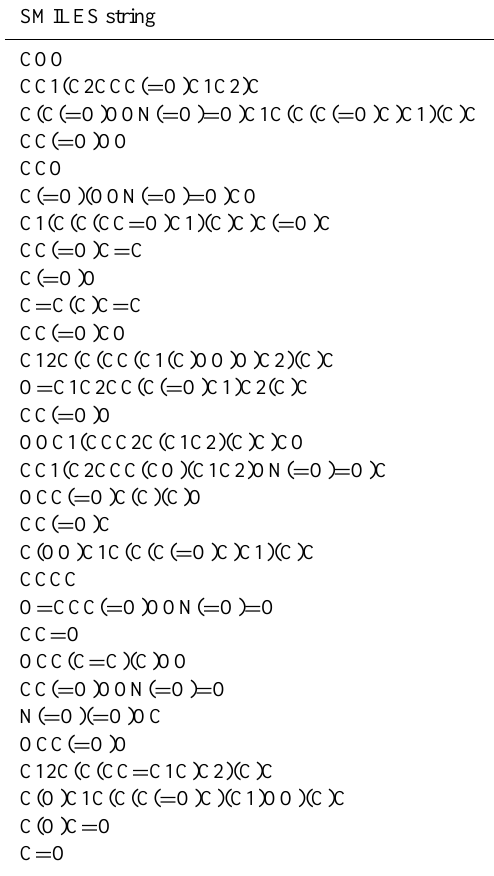
Table A1. To replicate the predicted vapour pressure and density predictions covered in Sect. 3.1, copy and paste these SMILES strings into a text file and follow the procedures outlined in the main body of text. Be sure to copy just the SMILES